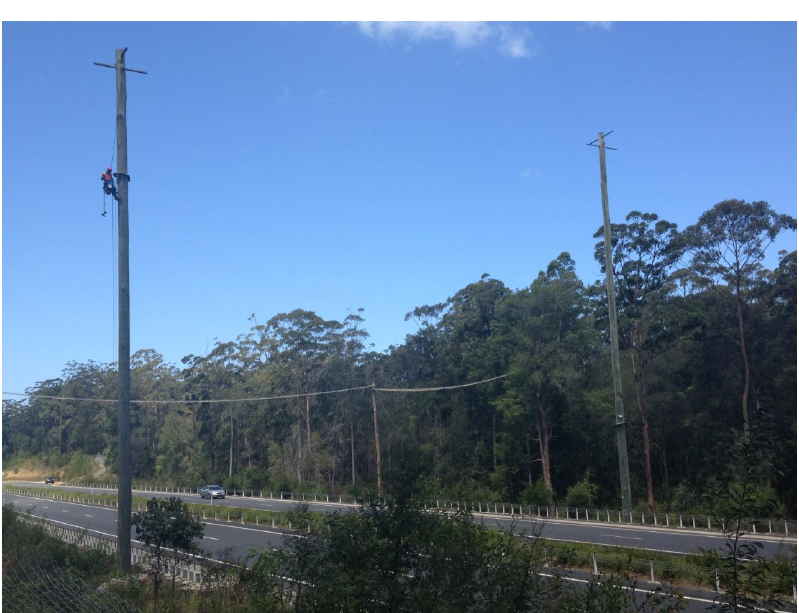
Figure 1. Example of a log bridge used by the Siberian Flying Squirrel ( Pteromys volans ) in Japan. The photograph shows a log bridge running through a culvert under a road for crossing. Photo captured and provided by Dr. Yushin Asari from Obihiro University of Agriculture and Veterinary Medicine.